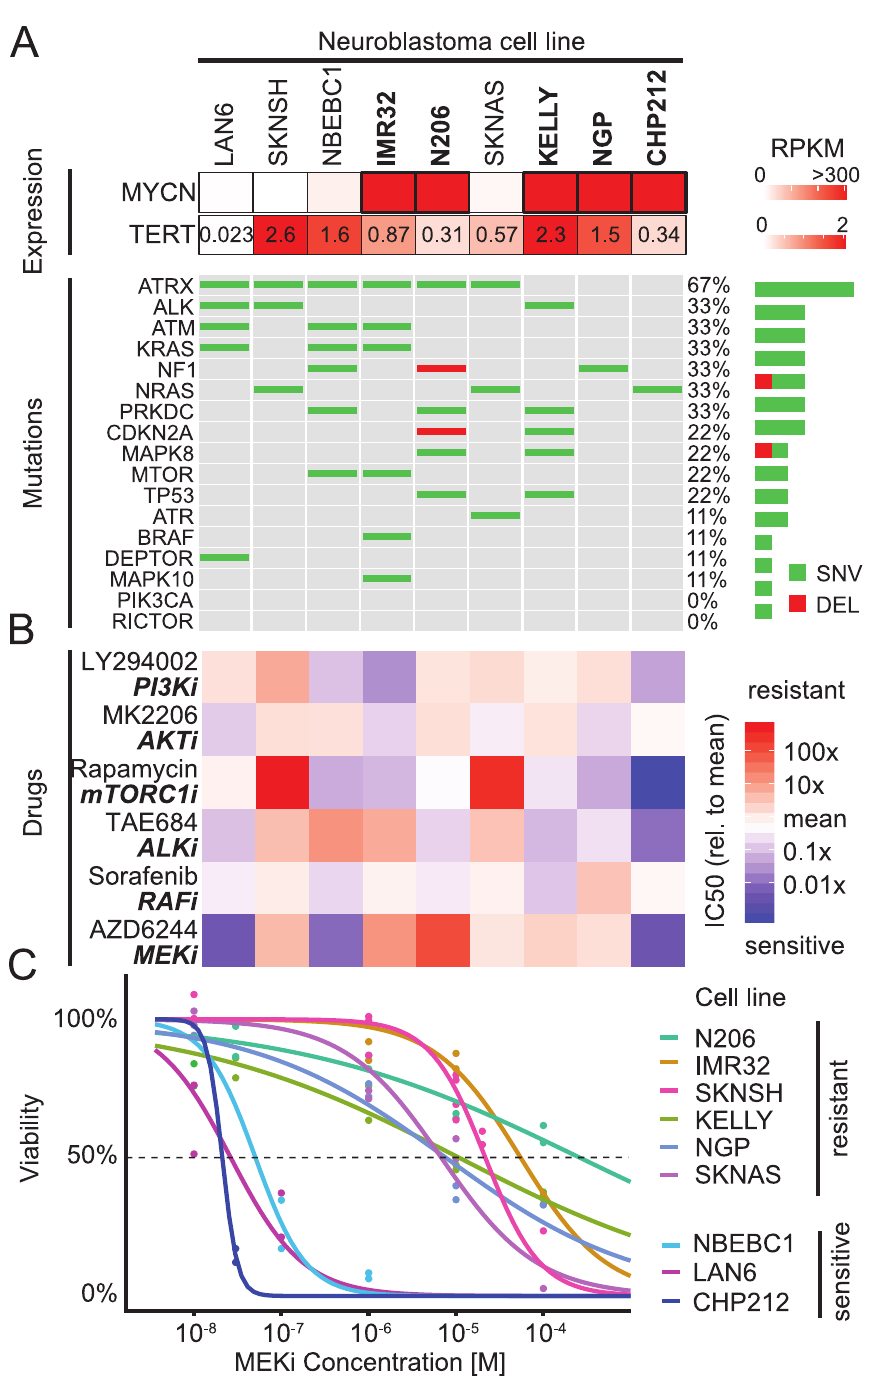
PLOS Computational Biology | https://doi.org/10.1371/journal.pcbi.1009515 November 4,